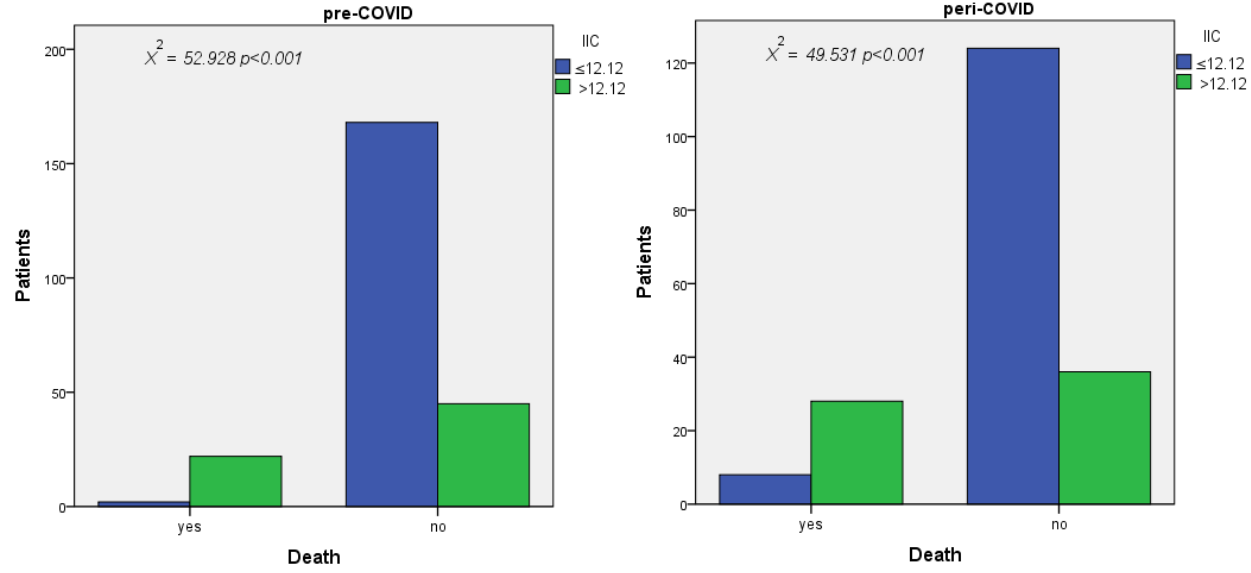
Figure 6. Correlation between mortality and IIC in the pre-COVID andperi-COVID group. X 2 —chi-square value. Table 8. Cutoff values of laboratory parameters for determining the risk of death in the pre-COVID (1) and peri-COVID (2) groups.